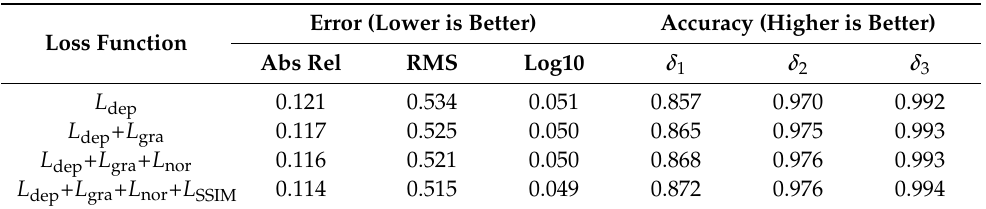
Table 5. Proposed method performance for different loss functions. SSIM: structural similarity. Each loss function is defined in Section 3.3.